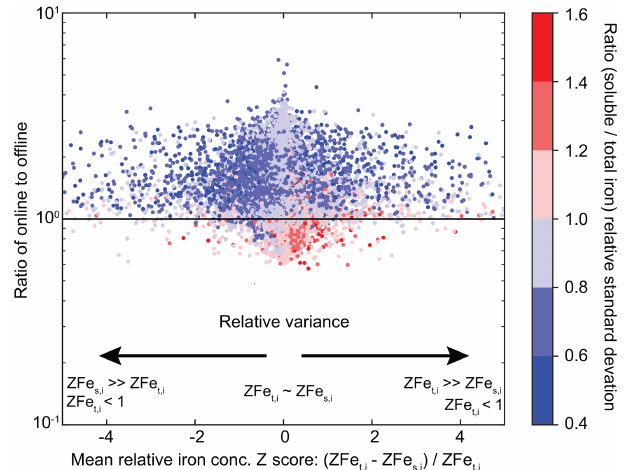
Figure 9. Relationship of online- to offline-derived iron solubility to the relative Z score for total ( Z Fe t ) and soluble ( Z Fe s ) iron and the relative standard deviation ( σ Fe / Fe) at each grid cell for the year 2007.